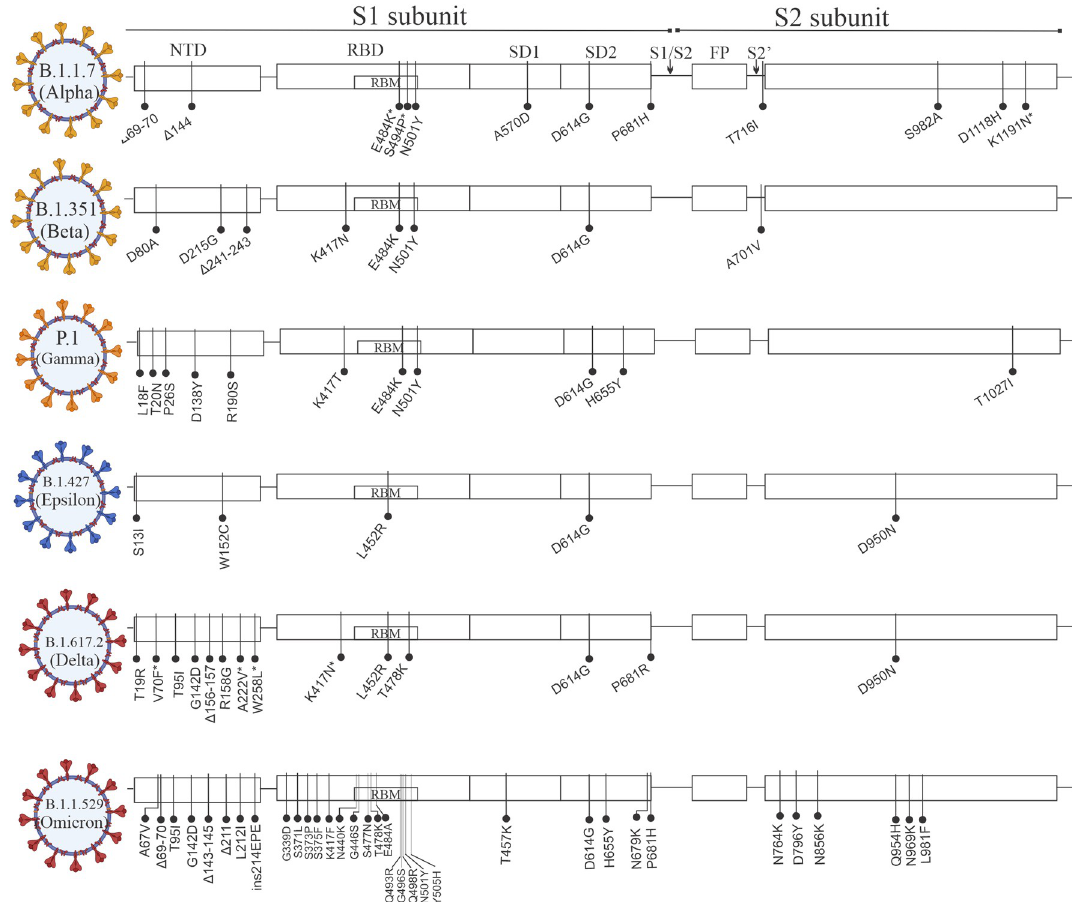
Fig 2. Schematic overview of the SARS-CoV-2 variants. The variant being monitored B.1.1.7 (Alpha), B.1.351 (Beta), P1 (Gamma), and B.1.427 (Epsilon) and the variant of concern B.1.617.2 (Delta) and B.1.1.529 (Omicron) showing amino acid modifications in comparison to the ancestral Wuhan-Hu-1 sequence (NC_045512.2). FP, fusion peptide; NTD, N-terminal domain; RBD, receptor- binding domain; RBM, receptor-binding motif; SARS-CoV-2, Severe Acute Respiratory Syndrome Coronavirus 2.